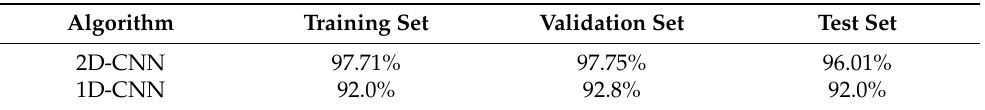
Table 7. The discrimination results of normal and cancerous breast tissues by PMRS image with 2D-CNN and conventional Raman spectroscopy with